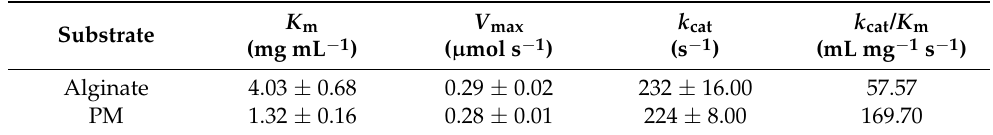
Table 4. Kinetic parameters of PMD towards alginate and